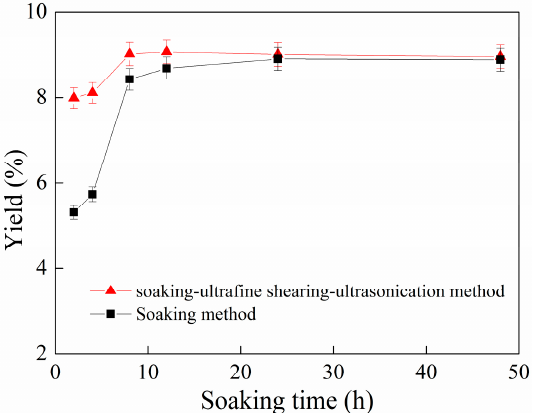
Figure 6. Relationship of soaking time and yield of C-PC based on the method of soaking-ultrafine shearing-ultrasonication. Error bars indicate standard deviations of the means ( n = 3).